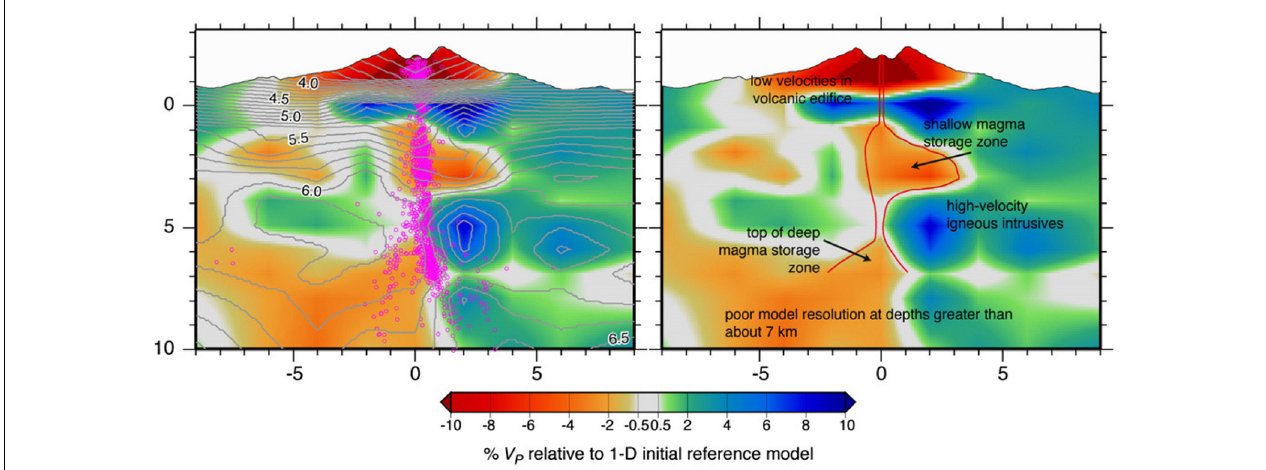
FIGURE 4 | West–east cross-section showing seismic velocity structure (left) and inferred magma storage zones (right) at Mount St. Helens, reproduced from Waite and Moran (2009). Pink open circles (left) indicate earthquakes from March 1980 through June 2004, plus selected events from July 2005 to January 2006; see Waite and Moran (2009) for selection criteria. Low-velocity region labeled “top of deep magma storage zone” corresponds to the upper crustal reservoir that fed the May 18, 1980, eruption. The 2004–2008 dome-forming eruption was fed from the region labeled “shallow magma storage zone.” Vertical axis, depth in kilometers below sea level. For more recent seismic imaging of the crustal magmatic system, generally consistent but more detailed than shown here, see Kiser et al. (2016,